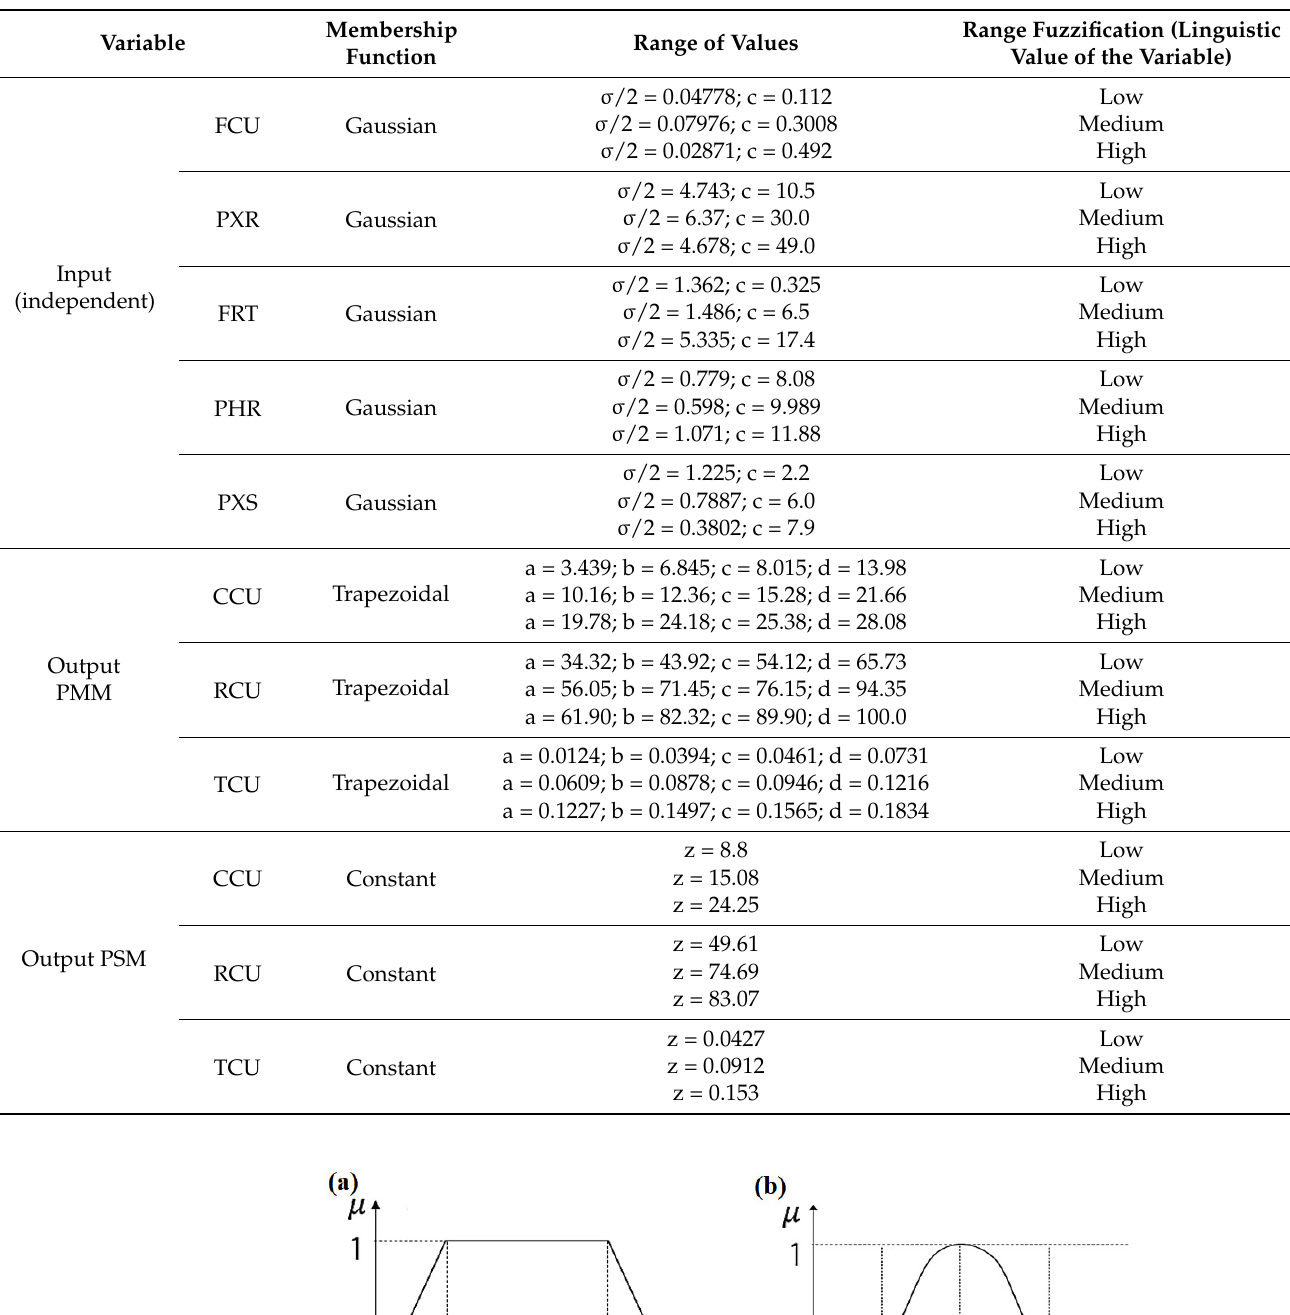
Table 5. Fuzzification of the range of variables in the PMM and PSM.